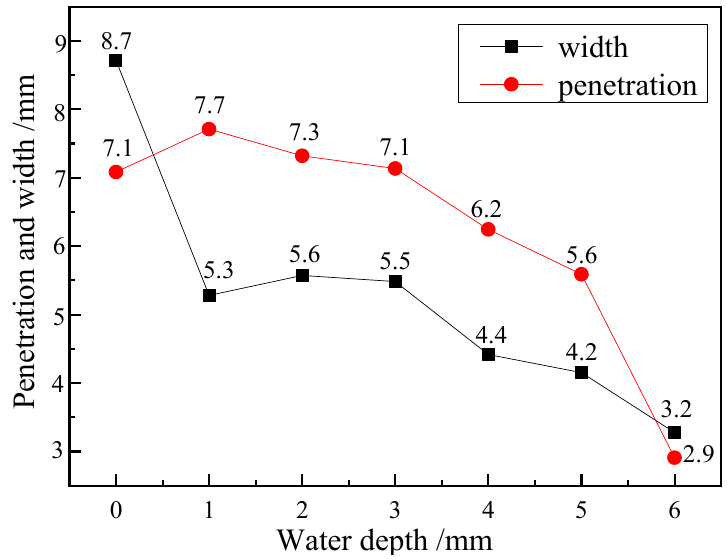
penetration welding cannot continue.